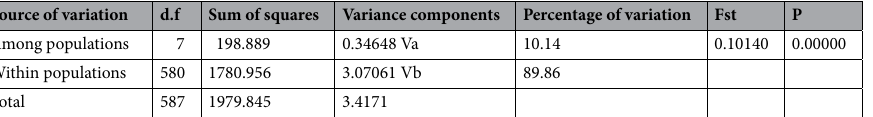
Table 5. AMOVA results for eight L. maculatus populations.